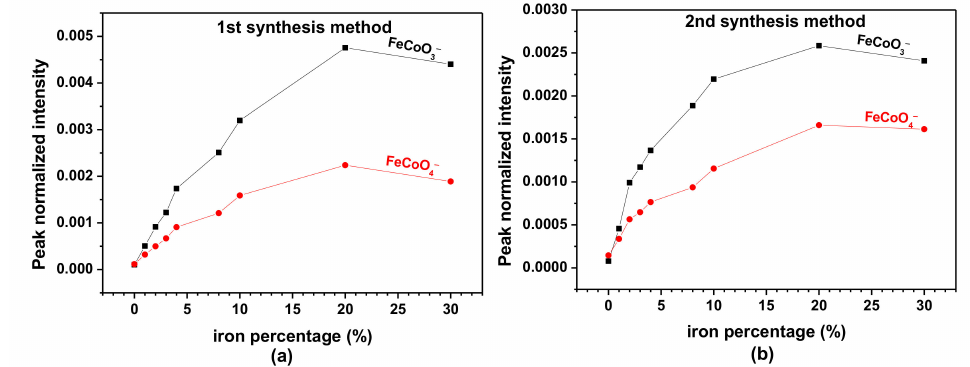
Figure 10. Variation of the intensities of the FeCoO 3 − and FeCoO 4 − ions normalized by the total spectrum intensity as a function of the Fe percentage for ( a ) the first synthetic route; ( b ) the second synthetic route.